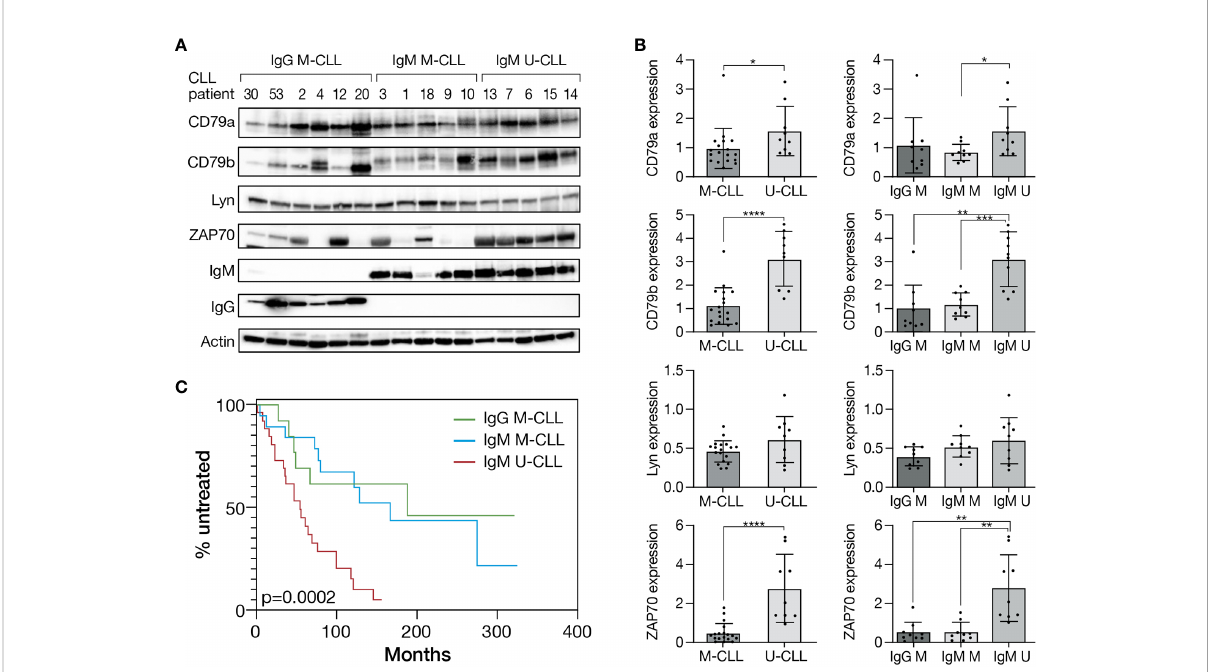
FIGURE 1 Different expression pattern of proximal BcR signaling proteins in CLL immunogenetic subtypes. (A) A representative Western blot analysis of primary CD19 + puri fi ed cells from M-CLL and U-CLL cases showing CD79a, CD79b, Lyn, ZAP70, IgM, and IgG levels. Actin was used to verify equal loading. (B) Quanti fi cation of CD79a, CD79b, Lyn, and ZAP70 levels in IgG M-CLL, IgM M-CLL, and IgM U-CLL cells in (A) by normalization to actin using myImageAnalysis ™ Software (n = 27). *p < 0.05, **p < 0.01, ***p < 0.001, and ****p < 0.0001. (C) Kaplan – Meier analysis of time to fi rst treatment according to IGHV gene SHM status and IG subclass(n =